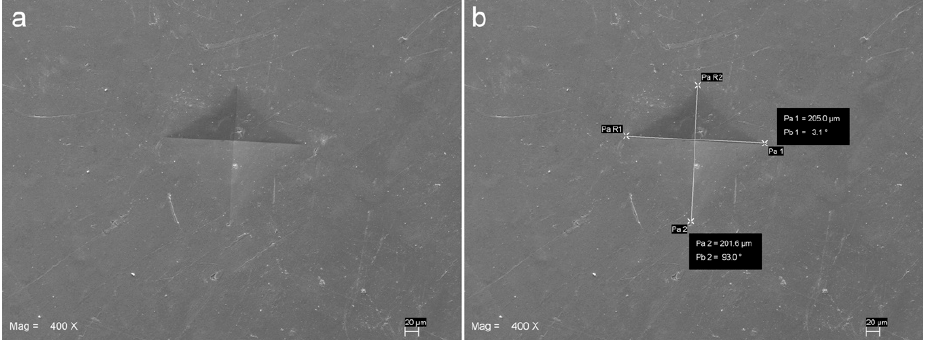
Figure 3. Scanning electron micro-graph showing the VH indentation ( a ) and the measurement of its diagonals ( b ) performed on a specimen from AUR group, 3 mm thick and cured for 10 s using a LED curing unit with 1500 mW/cm 2 output.